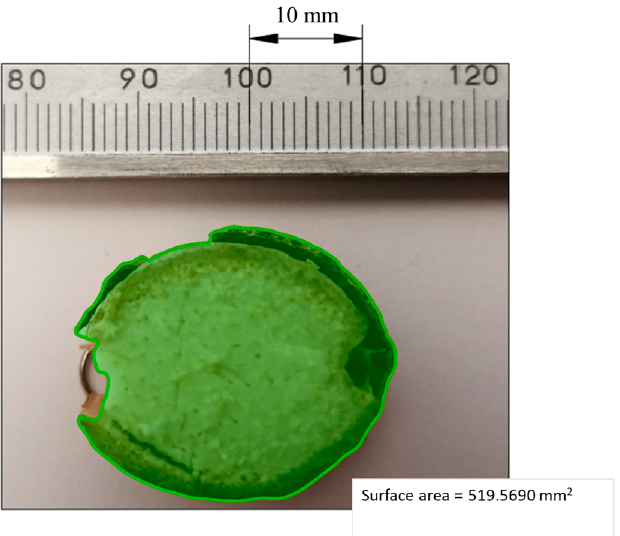
area of the stalk.